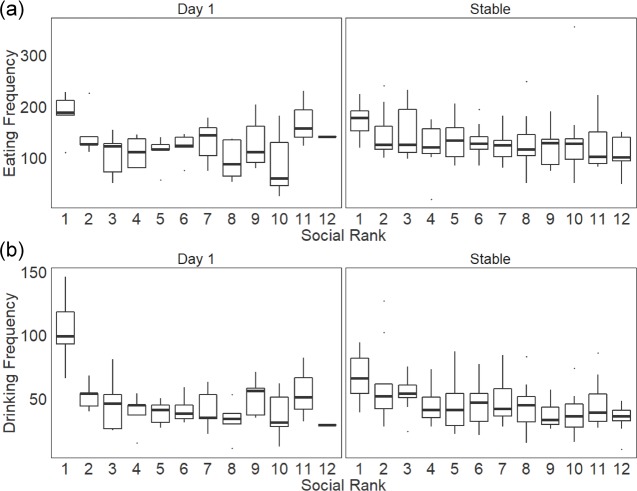
Frequency of bouts of (A) eating and (B) drinking on the day of video recording across social ranks on the first day of group housing (Day 1) and after social hierarchies were established (Stable).Social ranks were determined by individual Glicko ratings based on agonistic behavioral data collected until the day of the video recording. Boxplots show median (horizontal bars), interquartile ranges (boxes) and 95% confidence intervals (whiskers).